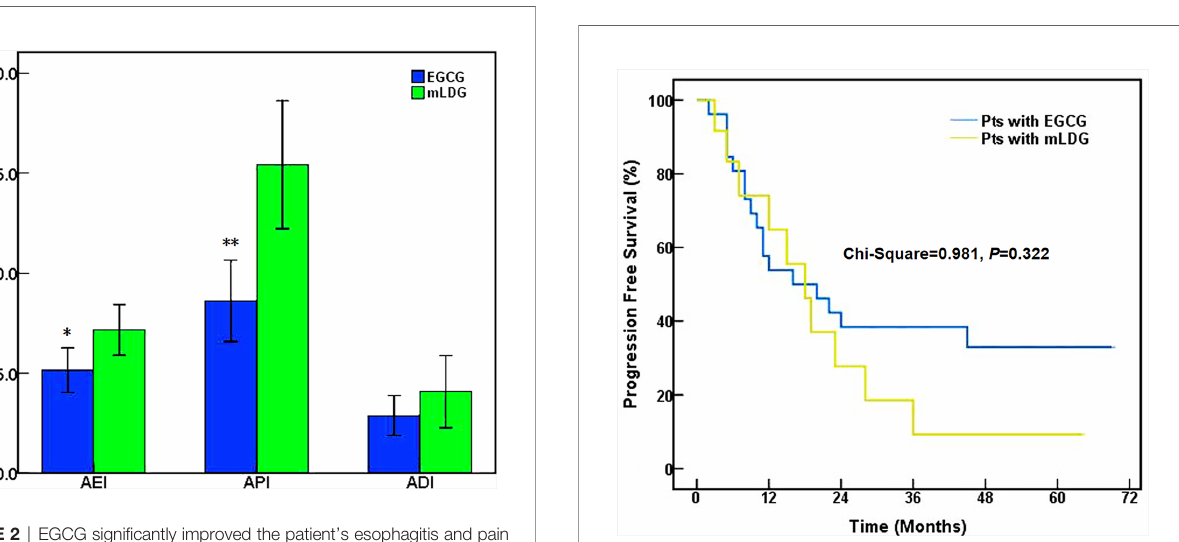
FIGURE 2 | EGCG signi fi cantly improved the patient ’ s esophagitis and pain compared with conventional treatment. The statistical differences were observed in the mean value of AEI and API between EGCG and mLDG groups (*P = 0.030; **P < 0.001).